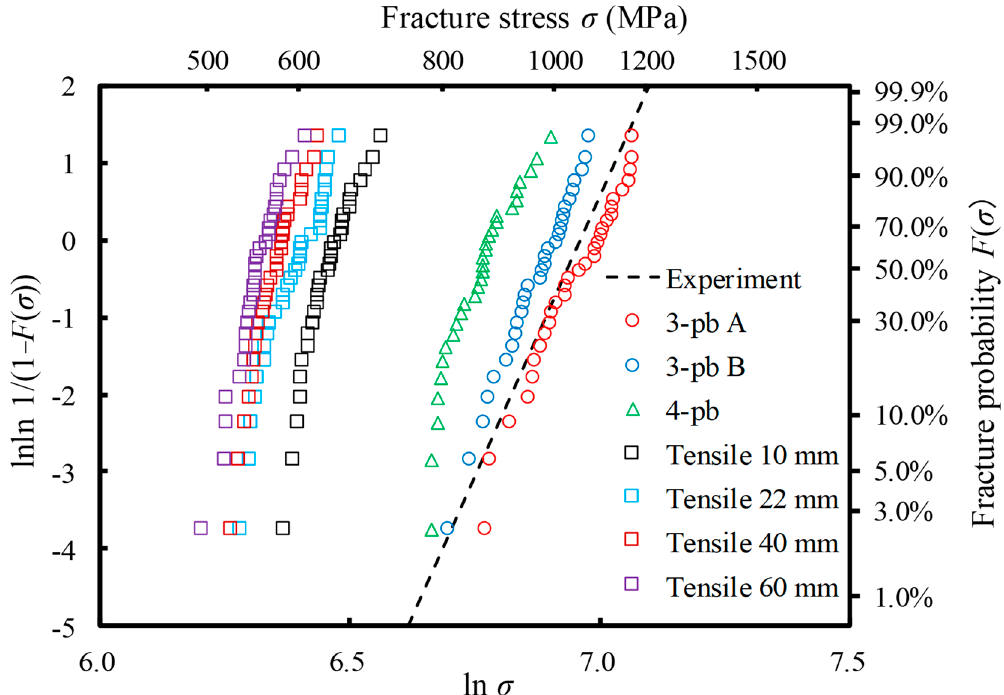
Figure A1. Histogram of the microstructure data of the elements obtained for an arbitrary specimen of the four-point bending test (length 40 mm) as shown in Figure 3. The distribution of the microstructure is defined as given in Table 2, while μ R = 0.8 and μ R + 3 σ R = 7.87 for the pore size: